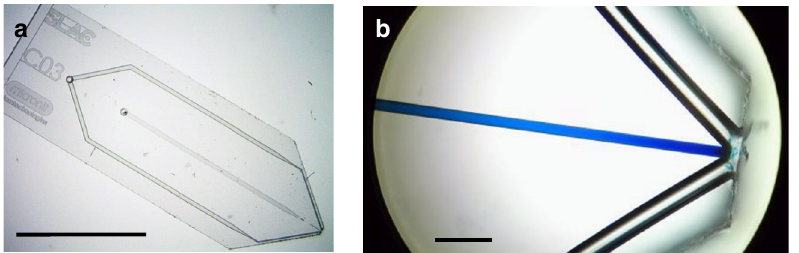
Fig. 1 Micro fl uidic gas-dynamic nozzle. The micro fl uidic device for generating free- fl owing liquid sheets is shown in a . The gas and liquid ports are on the underside of the chip on the left. Micro fl uidic channels for gas (outer), and liquid (central) can be traced to the output of the nozzle on the right side of the chip. The chip dimensions are 6×19 mm, and the scale bar is 6 mm. A close-up of the nozzle output is shown in b , where a blue dye has been introduced into the liquid channel. The scale bar in b is 100 μ m